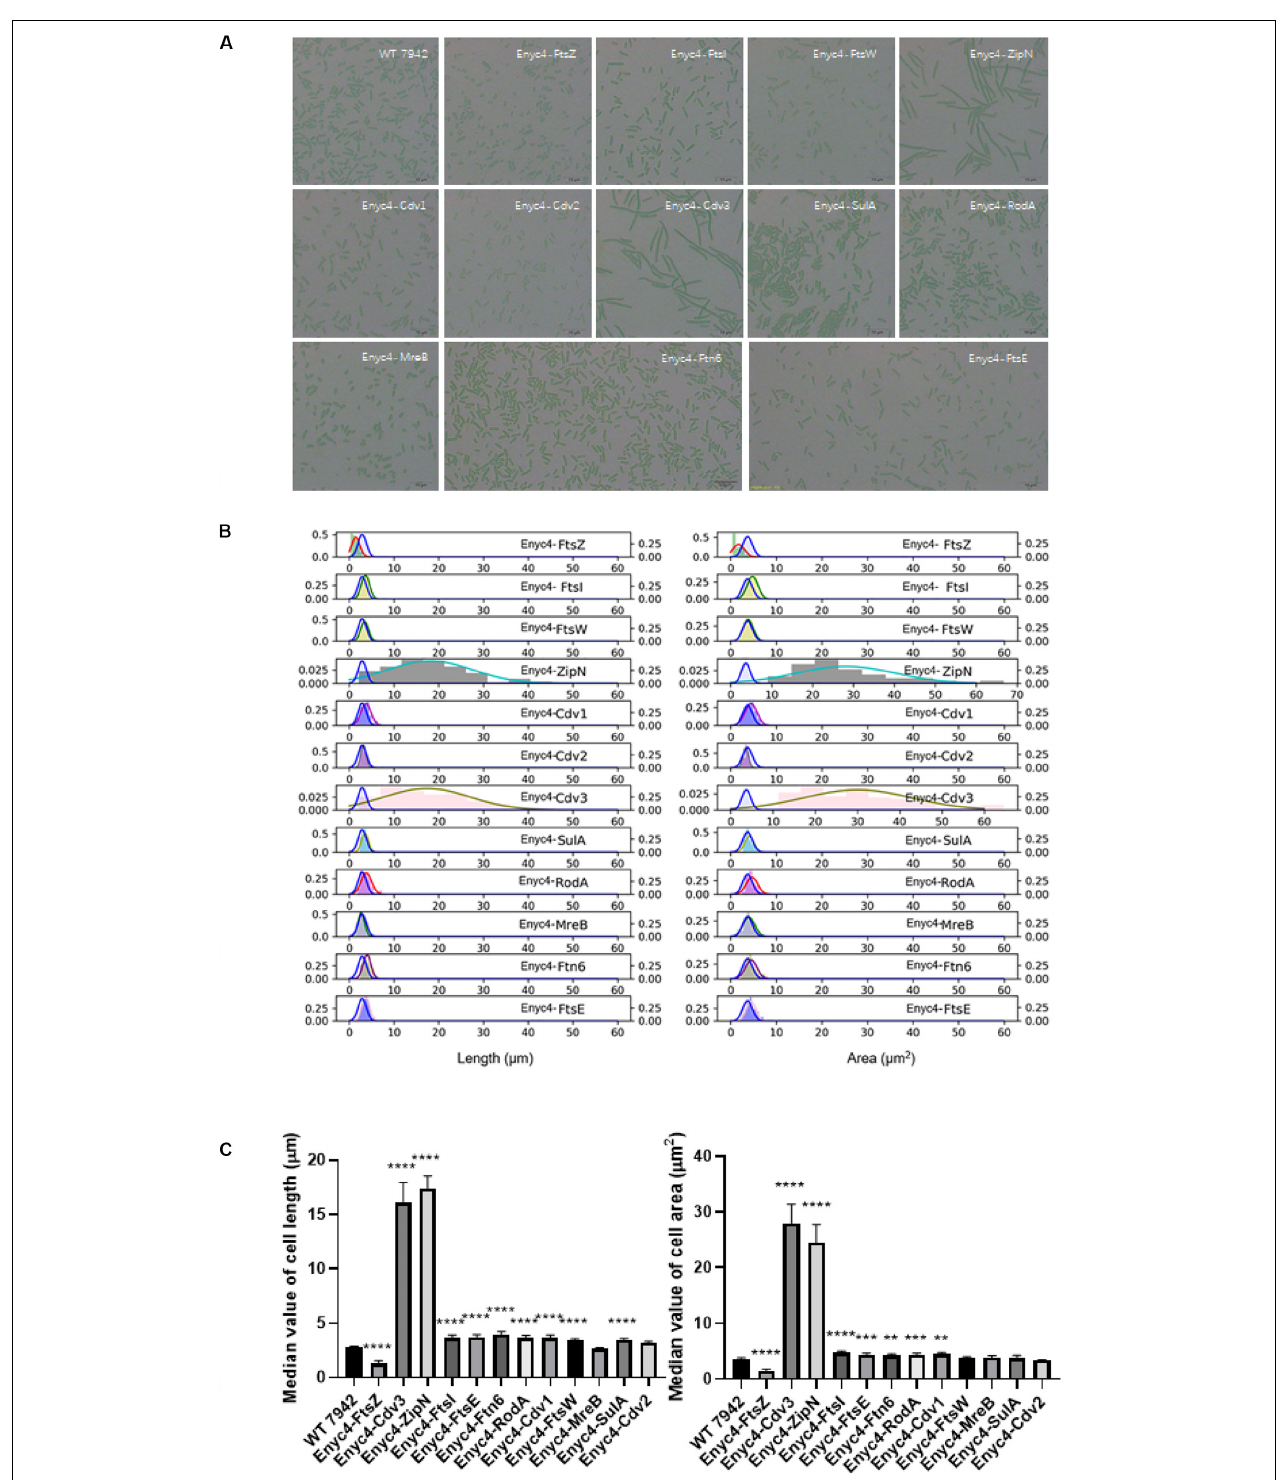
FIGURE 3 | The overexpression effects of the candidate genes on cellular morphology of PCC7942. (A) Microscopic photo of the wild type PCC7942 and overexpression mutants. (B) The distribution histogram and normal distribution curve of the cell length (left) and the cell area (right) in the mutant strains compared with the wild type strain (blue line). At least 100 cells were evaluated for statistical analysis. The right left and right Y axes indicates the probability of the mutants and the wild type, respectively. (C) The comparison of cell length (left) and cell area (right) between wild type and riboswitch-regulated strains based on the values of median and the SEC. The Kruskal-Wallis test in One-way ANOVA was used to analyze the significant difference. * indicates < 0.05; ** indicates < 0.01; *** indicates < 0.001; **** indicates < 0.0001.